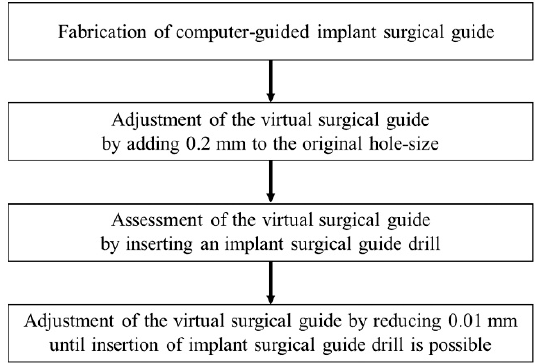
Figure 1. Schematic of the procedure.